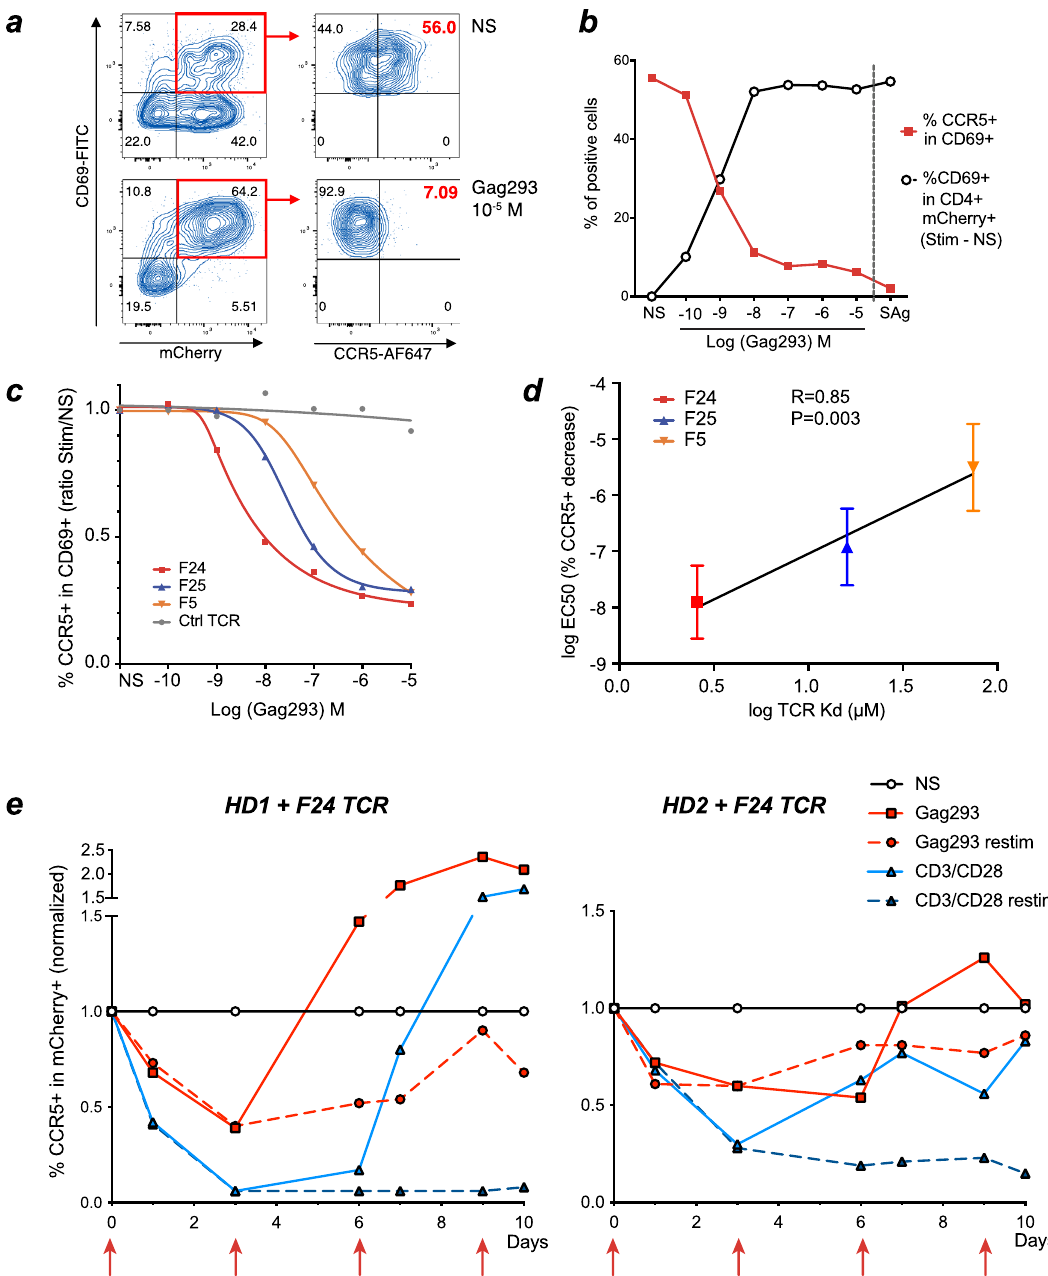
Fig. 8 Strong TCR signals induce CCR5 downregulation. a – d Analysis of CCR5 downregulation in HD PBMC transduced with Gag293-speci fi c TCRs and activated with Gag293-loaded APC. a Gating strategy: TCR-dependent activation was measured by CD69 induction in TCR-transduced (mCherry + ) CD4 + T cells (left). CCR5 downregulation was measured in activated mCherry + CD69 + CD4 + T cells (right). NS Non-stimulated. b Example of quantitation of T cell activation (%CD69 + in Stim - NS Black curve) and of CCR5 down-regulation (%CCR5 + in CD69 + ) in TCR F24-transduced PBMC, in function of Gag293 concentration. Superantigens (SAg) were used as positive control. c Analysis of CCR5 downregulation as in B, for PBMC transduced with 3 Gag293-speci fi c TCRs of increasing af fi nity (F5 < F24 < F24) or with a control fl u-speci fi c TCR (Ctrl) in an HLA-DR15 context. One representative experiment out of n = 3 is shown. The % CCR5 + cells in CD69 + mCherry + CD4 + T cells is normalized to that measured in the unstimulated condition (NS). d Correlation between TCR af fi nity (Kd) for the Gag293/HLA-DR15 complex and the Gag293 EC50 concentration for CCR5 downregulation (as determined in c ). Means ±SD are shown for n = 3 experiments. The linear regression coef fi cient R and associated P -value for the slope being signi fi cantly ≠ 0 are reported. e Kinetics of CCR5 downregulation in TCR transduced CD4 + T cells upon antigenic stimulation. TCR-transduced CD4 + T cells (mCherry + CD4 + ) were monitored for CCR5 expression after stimulation at day 0 with either the cognate peptide (Gag293; solid red lines) or anti-CD3/anti-CD28 coated beads (CD3/CD28; solid blue lines). Kinetics are shown in transduced cells of n = 2 healthy donors, HD1 (left), and HD2 (right). The proportion of CCR5 + cells as compared to the unstimulated condition (NS) is reported. In the “ restim ” conditions (dashed lines), cultures were restimulated at days 3, 6, and 9, as indicated by red vertical arrows.